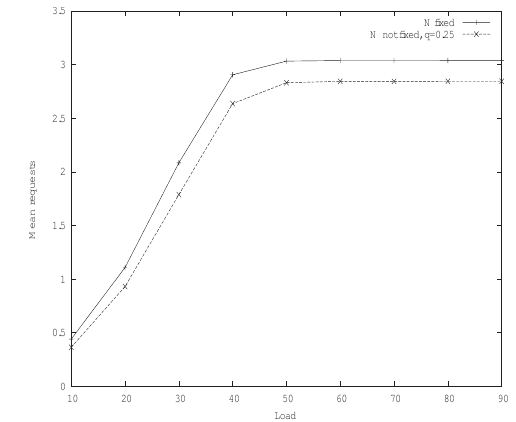
Figure 13. Mean Requests ratio of both